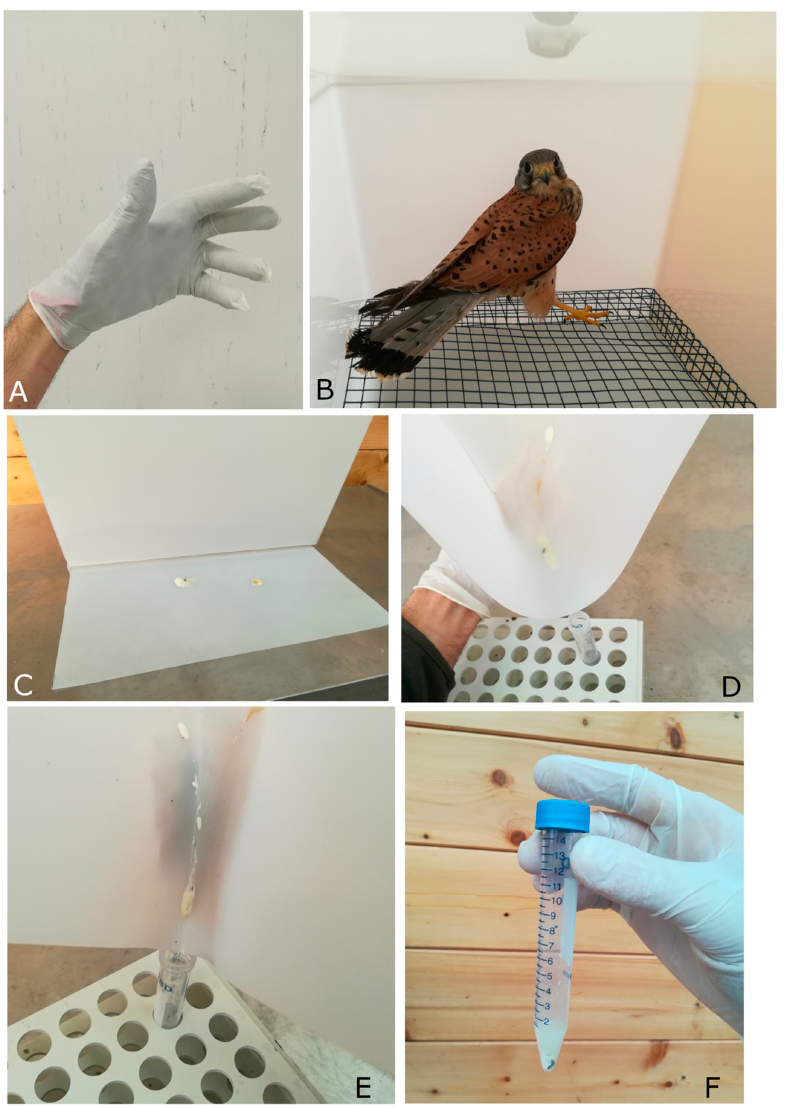
Figure 2. ( A ) The latex gloves cover the leather gloves; ( B ) wild bird (common kestrel, Falco tinnunculus ) placed in the box; ( C ) fresh feces dropped on the plastic tray; ( D and E ) the plastic tray is folded, funnel-like, and the feces are easily removed and collected in the sterile tube; ( F ) the final feces sample obtained ready to be stored or processed.